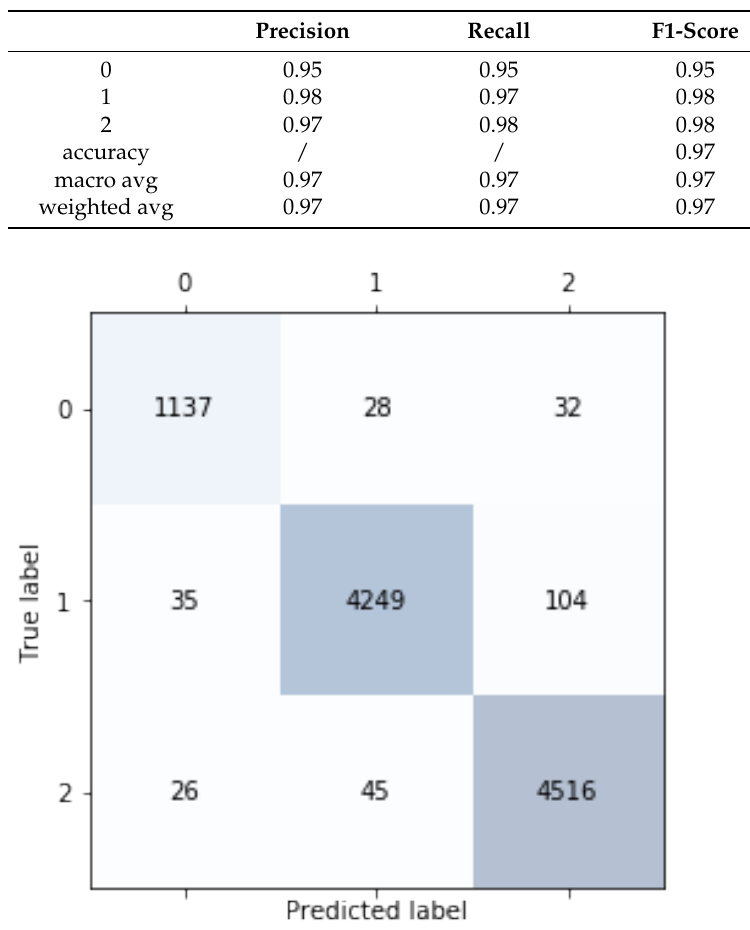
Figure 9. Confusion matrix for CNN-LSTM bitcoin tweets.